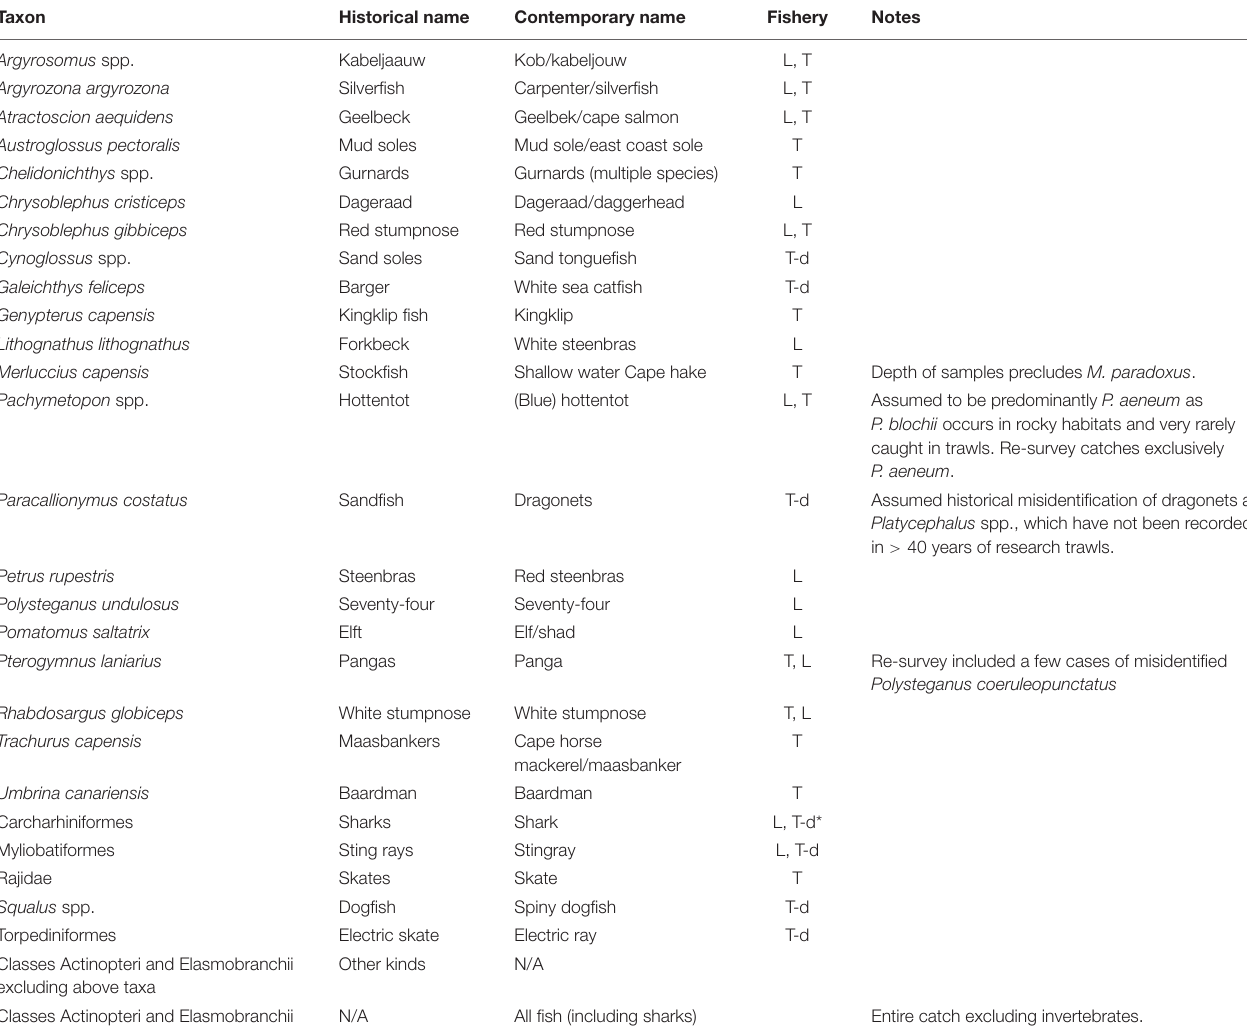
TABLE 1 | The resolution of taxa used in analyses, including their historical and contemporary common